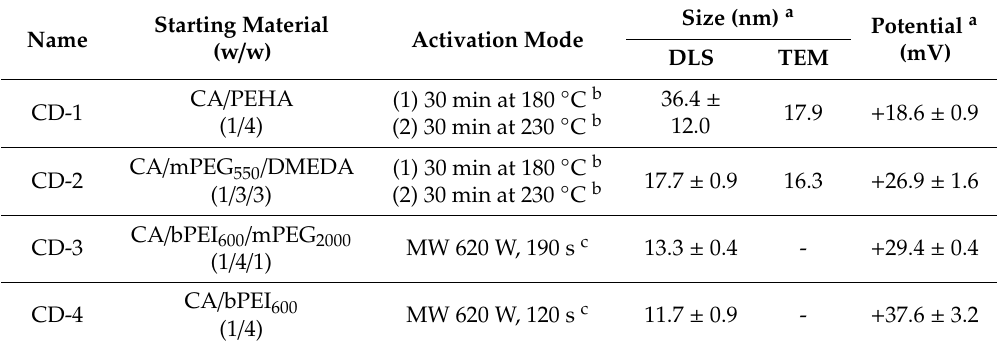
Table 1. Characteristics of the various carbon dots (CD-1 to CD-4) employed in the